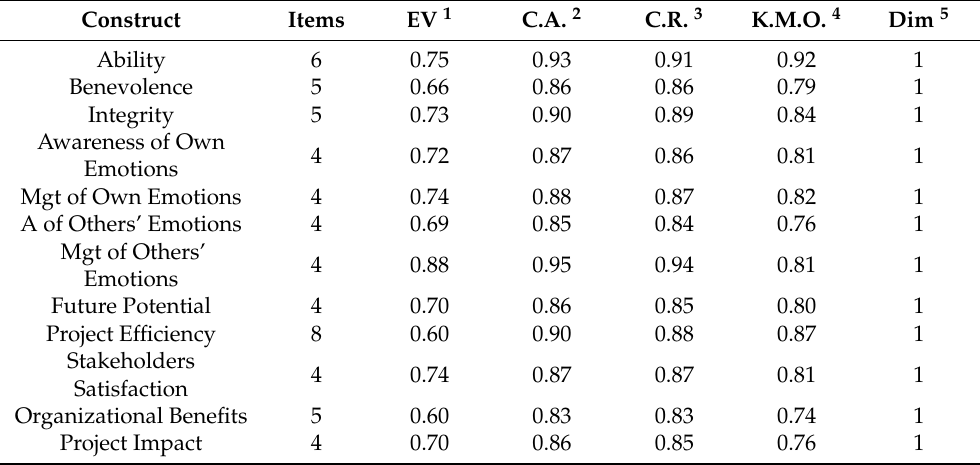
Table 1. Convergent validity, reliability, and dimensionality of 1st-order constructs.